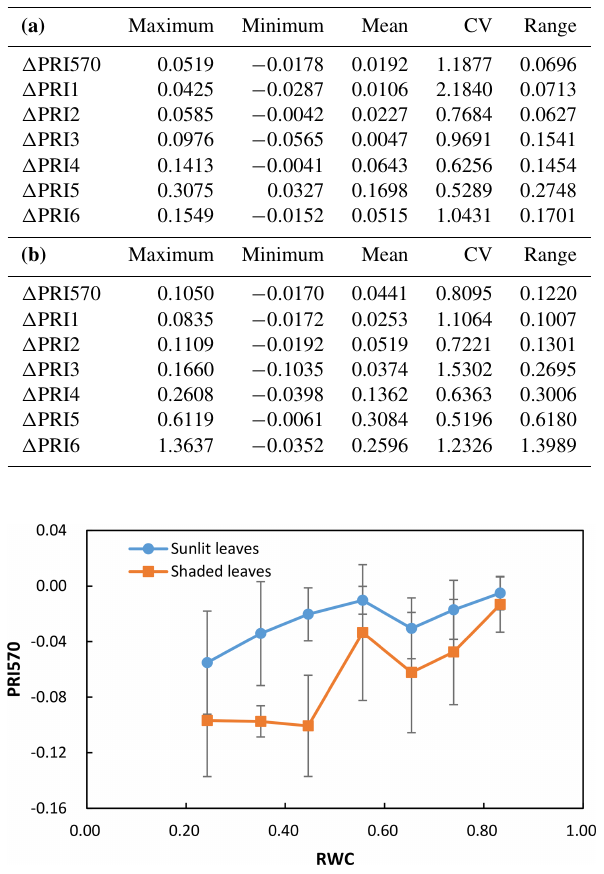
Figure 3. The mean and the standard deviation of PRI570 in sun- lit leaves and shaded leaves against RWC. Data were divided into seven groups according to RWC values (RWC ranges of 0.2–0.3, 0.3–0.4, 0.4–0.5, 0.5–0.6, 0.6–0.7, 0.7–0.8, and >0.8).